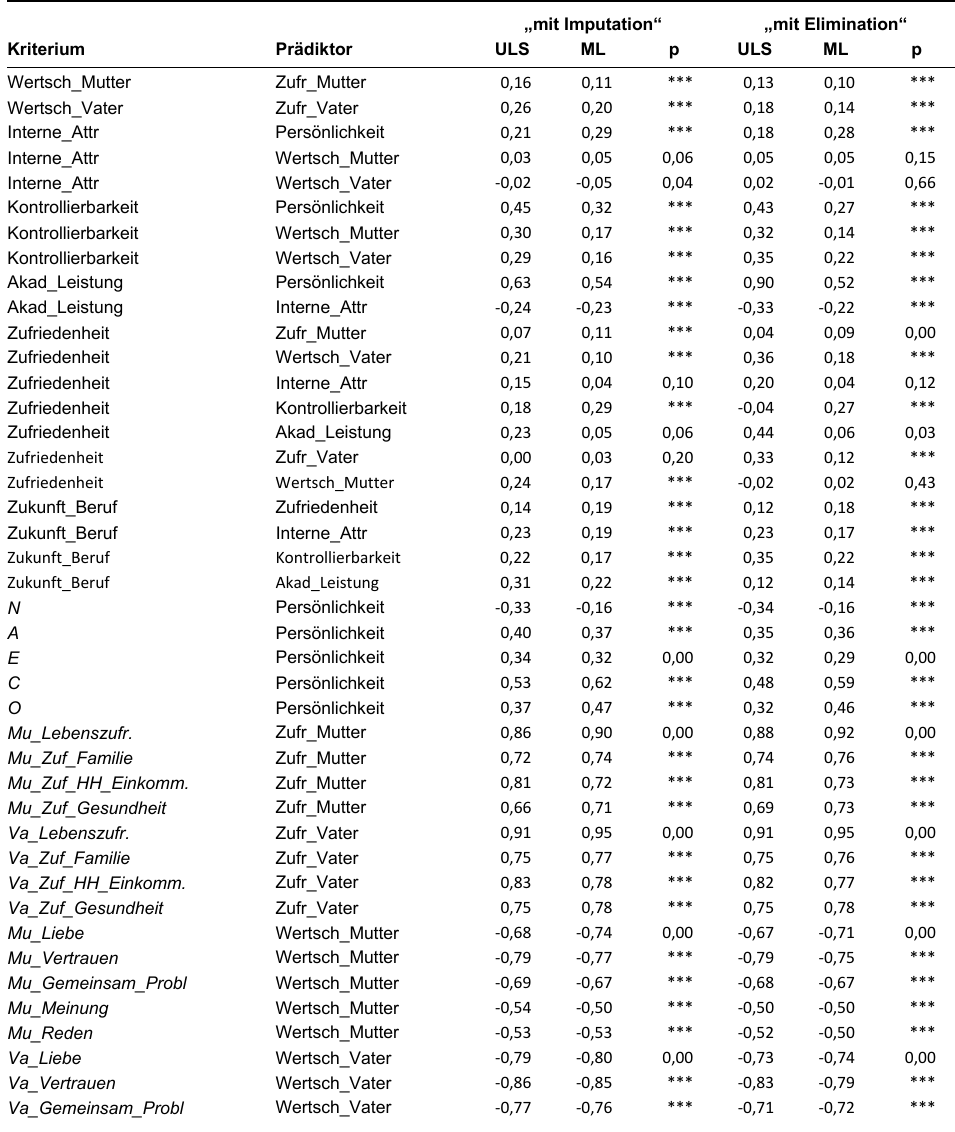
Tabelle 4 : Standardisierte Regressionsschätzer für die ULS und die ML-Methode für den „Datensatz mit Imputation“ (N=2139) und den „Datensatz mit Elimination“ (N=1599) sowie p-Werte für die ML-Methode für die nichtstandardisierten Schätzer (kursiv – gemessene Variablen) ‒ (die